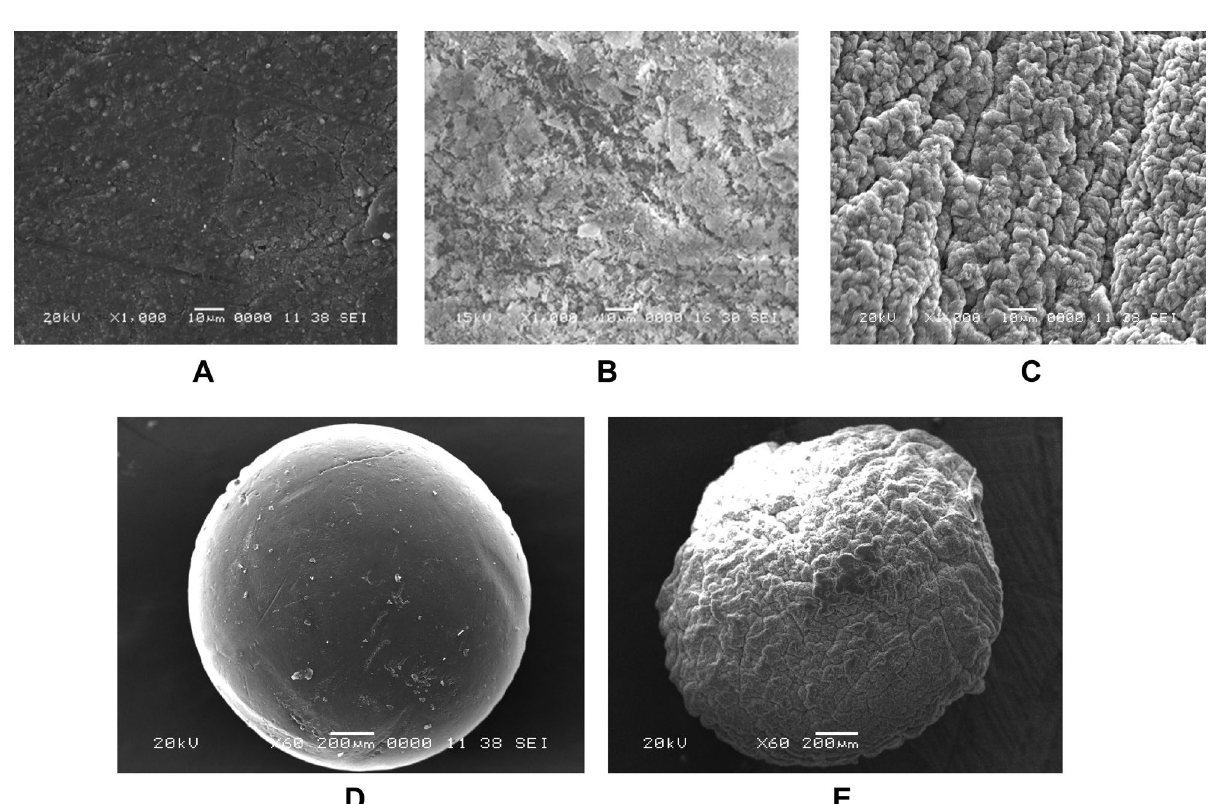
Figure 4. SEM images of ( A , D ) pure AM-CST beads, ( B ) kaolin and ( C , E ) K@AM-CTS composite beads at different